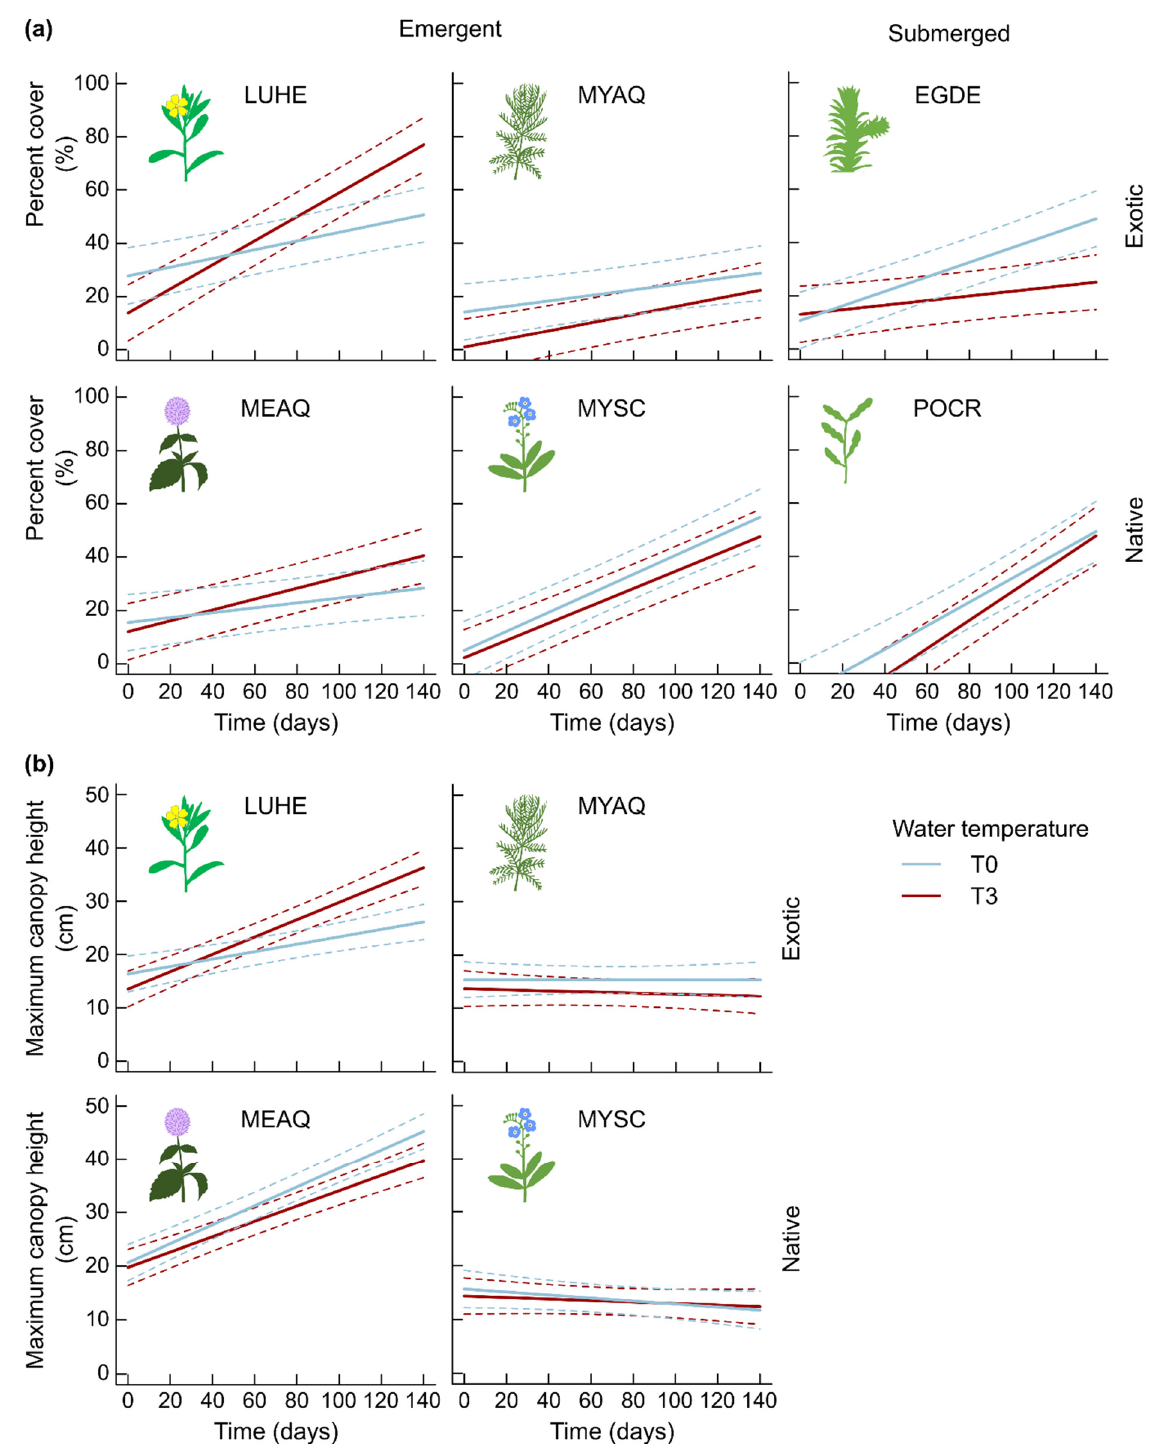
Figure 2. Prediction ( ± 95% CI) of vegetation percent cover by species ( a ) and maximum canopy height of the four emergent species ( b ) over time by linear mixed-effect models for species exposed to two water temperature treatments (ambient temperature T0, 3 °C warming T3) over 20 weeks (n = 5). Conditional R 2 (fixed and random effects) = 0.61 ( a ) and = 0.62 ( b ) The solid lines represent predicted means, and dashed lines represent 95% confidence intervals. LUHE = Ludwigia hexapetala , MEAQ = Mentha aquatica , MYAQ = Myriophyllum aquaticum , MYSC = Myosotis scorpioides , EGDE = Egeria densa , POCR = Potamogeton crispus (POCR).